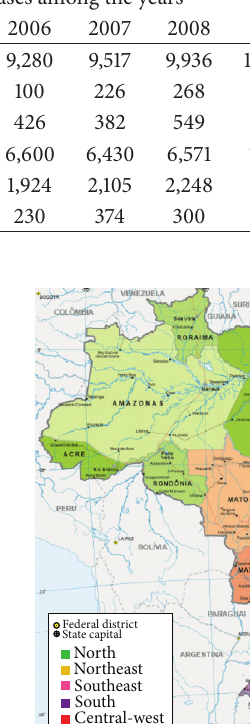
Table 2: Hepatitis C confirmed cases in Brazil according to the Ministry of Health [5]. Region